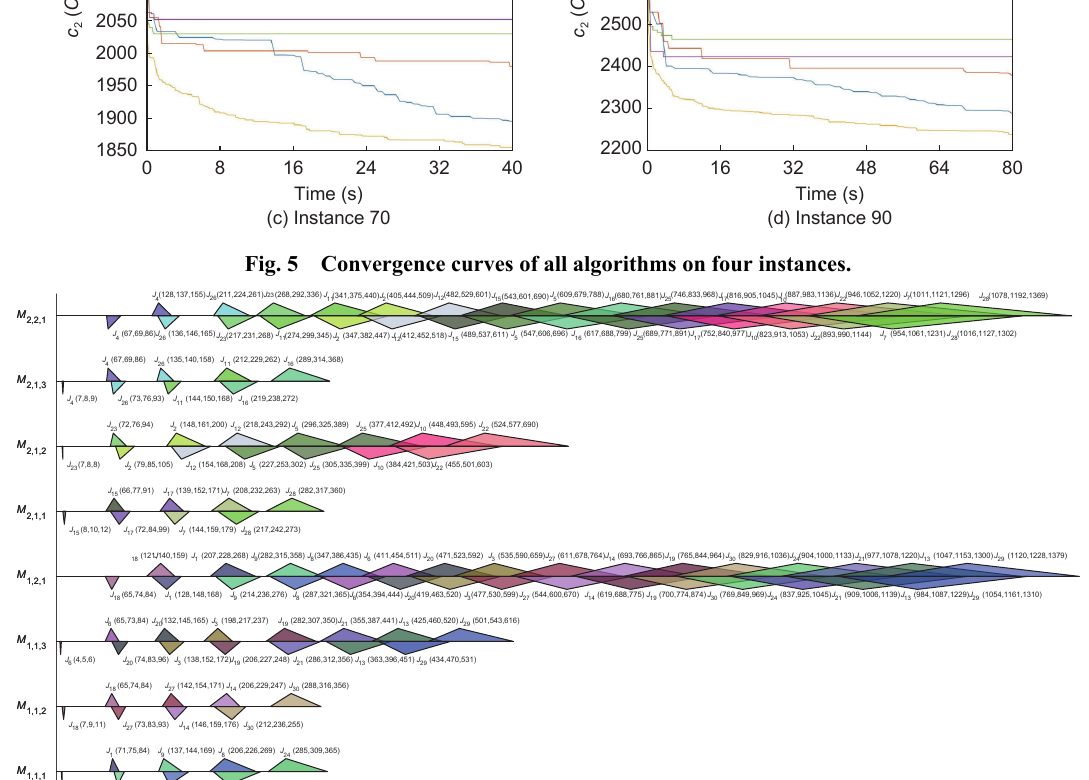
Fig. 6 Gantt chart of the best solution of instance 1 obtained by Q-learning-based teaching-learning based optimization